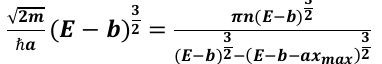
Figure: 1. Dislocation structure of α-Fe: a - unirradiated state; b - after irradiation in a glow discharge at a voltage of 1 kV at a distance of 8.19 mm from the irradiation